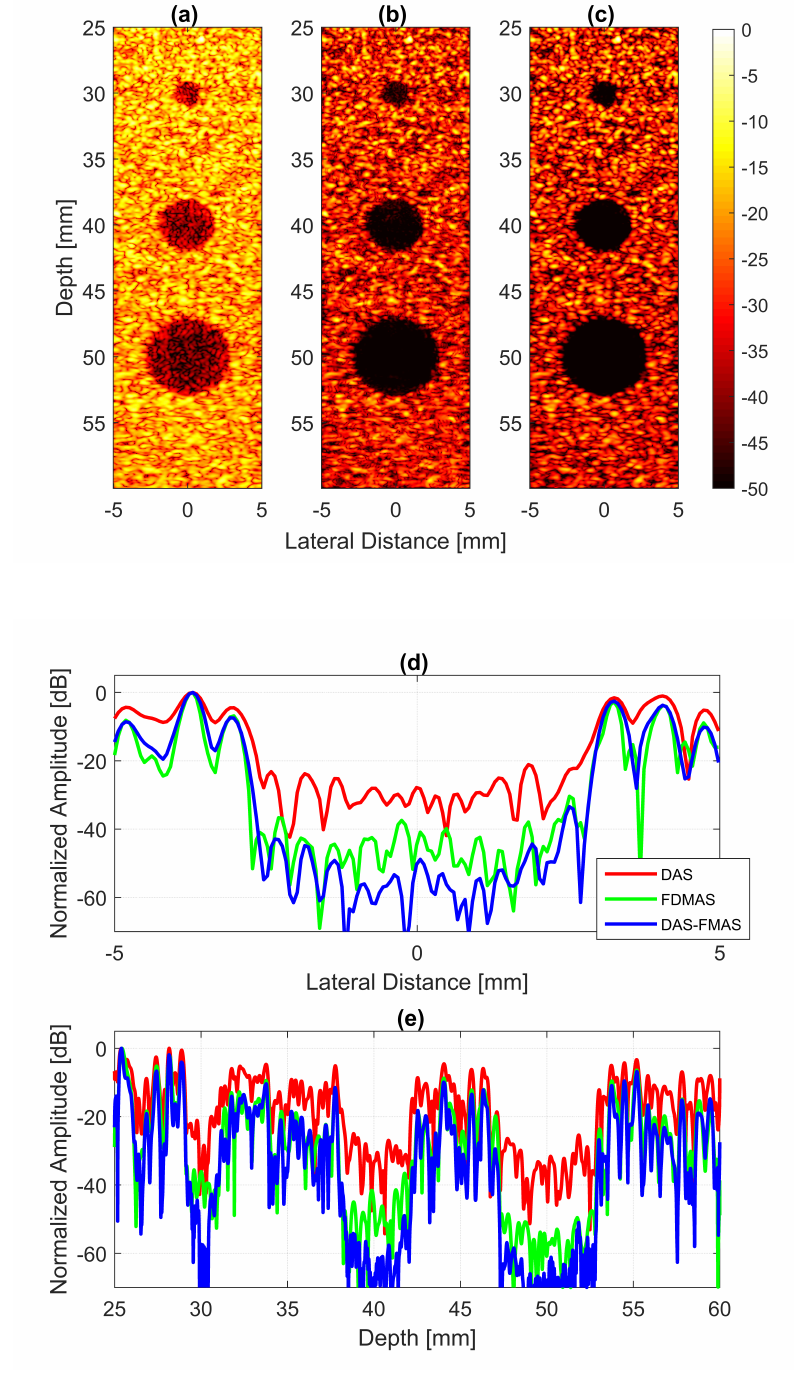
Figure 7. Field II simulations were performed on cysts located at depths of 30 mm, 40 mm and 50 mm with diameters of 2 mm, 4 mm and 6 mm with ( a ) DAS, ( b ) FDMAS and ( c ) DAS-FMAS. The number of steering angles was N = 3 ( − 12 ◦ , 0 ◦ , + 12 ◦ ). ( d ) Lateral beam profiles for the 6 mm cyst at a 50 mm depth and ( e ) axial beam profiles along x = 0